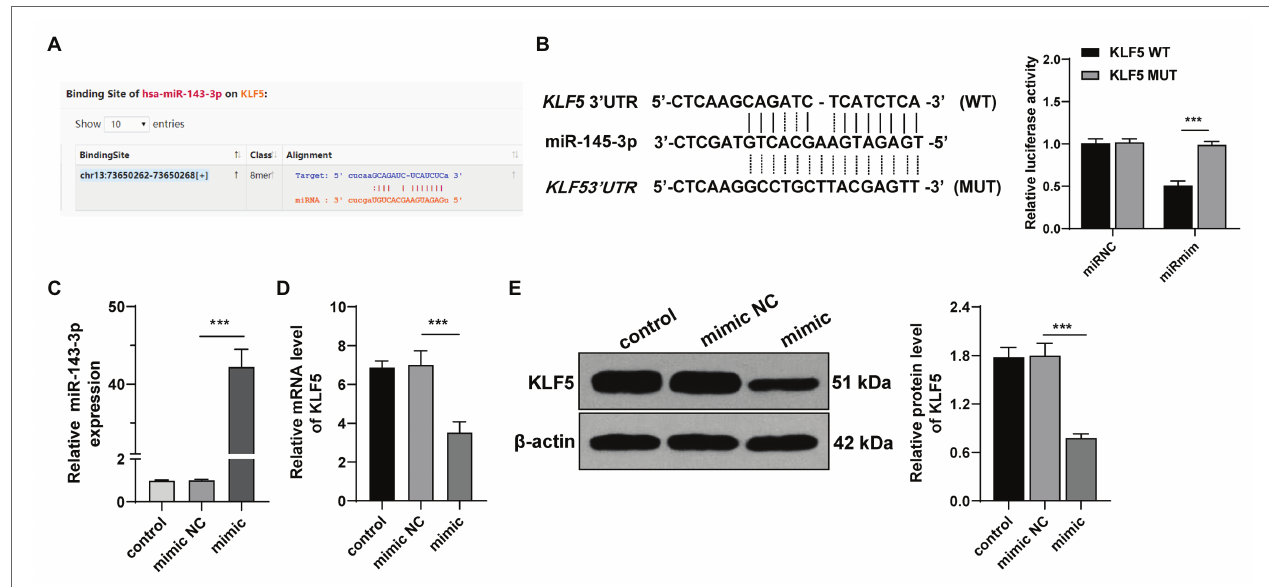
FIGURE 3 | miR-143-3p targeted KLF5 in hPDLCs. (A) Binding site of miR-145-3p and KLF5 was predicted by Starbase. (B) Binding relationship between miR- 145-3p and KLF5 was verified using dual-luciferase reporter gene assay. (C) Effect of miR-145-3p mimic on miR-145-3p was measured using RT-qPCR. (D) Effect of miR-145-3p mimic on mRNA level of KLF5 was measured using RT-qPCR. (E) Effect of miR-145-3p mimic on protein levels of KLF5 was measured using Western blotting. The experiment was repeated three times. Data are expressed as mean ± standard deviation. One-way ANOVA was applied to assess data in panel (B) , followed by Tukey’s multiple comparisons test, and two-way ANOVA was applied to assess data in panels (C–E) , followed by Sidak’s multiple comparisons test or Tukey’s multiple comparisons test, *** p <